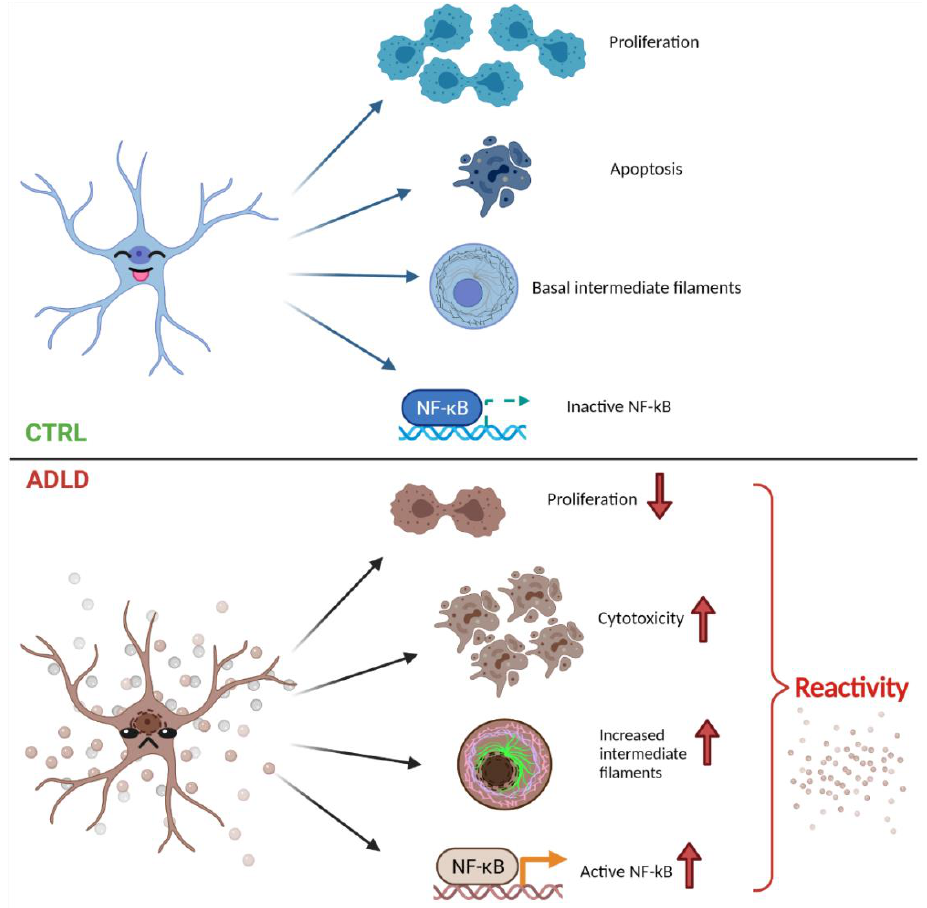
Figure 6. Lamin B1 accumulation causes astrocytes’ reactivity: Lamin B1 build up affects proliferation and cell cycle progression. These events are also associated to a reduction of cell viability and an induction of apoptosis, suggesting a great sufferance of this specific cell population under the effect of Lamin B1 accumulation. Moreover, astrocyte-like cells overexpressing Lamin B1 show increased immunoreactivity for both GFAP and vimentin, together with NF-kB phosphorylation, suggesting the induction of astrocytes reactivity and cellular activation. Image created with